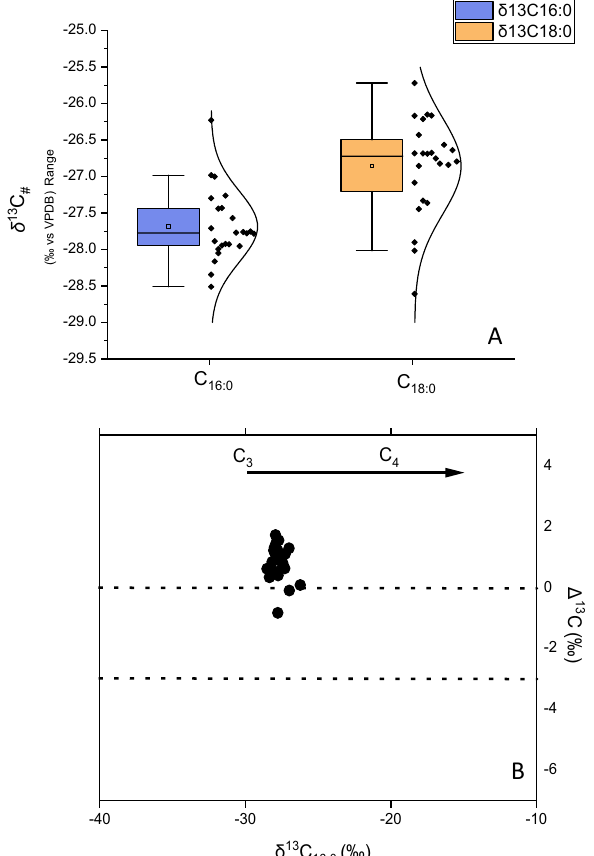
Figure 5. Stable carbon isotope composition (δ 13 C values) of individual fatty acids in sediments excavated from at AGS. ( A ) δ 13 C 16:0 and δ 13 C 18:0 values are shown as medians with their median absolute deviation (± MAD) and ANOVA test distributions. Boxplots depict distributional differences between individual homologue δ 13 C # values. ( B ) Qualitative isotopic source allocation of dominant fatty acids extracted from sediments at AGS. Graphical framework modified from Evershed and colleagues 43–45